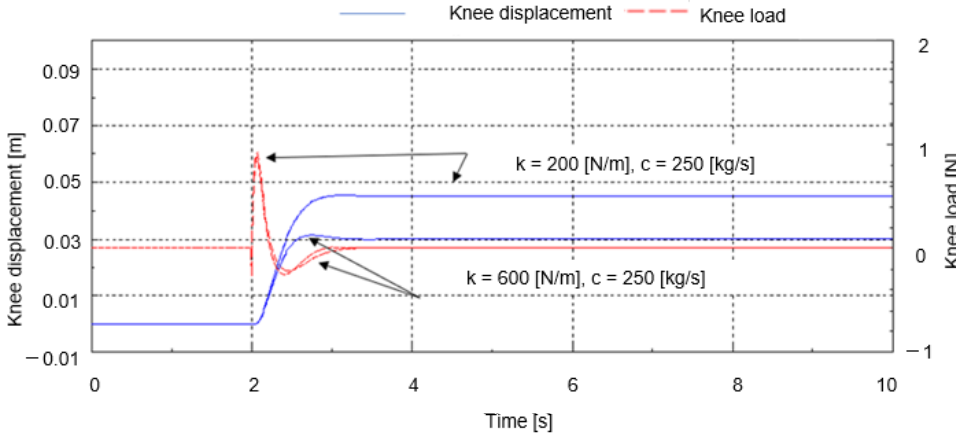
Figure 19. Comparison of device dumper and spring constant.